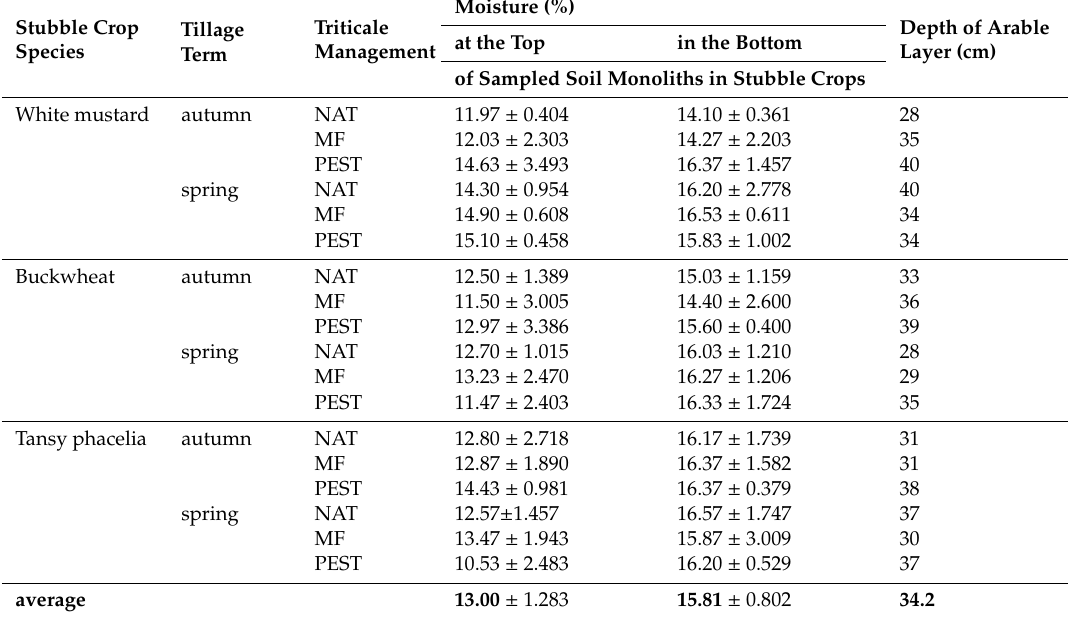
Table 3. Soil moisture and depth of arable layer in sampling sites in the second sampling series (in stubble crop